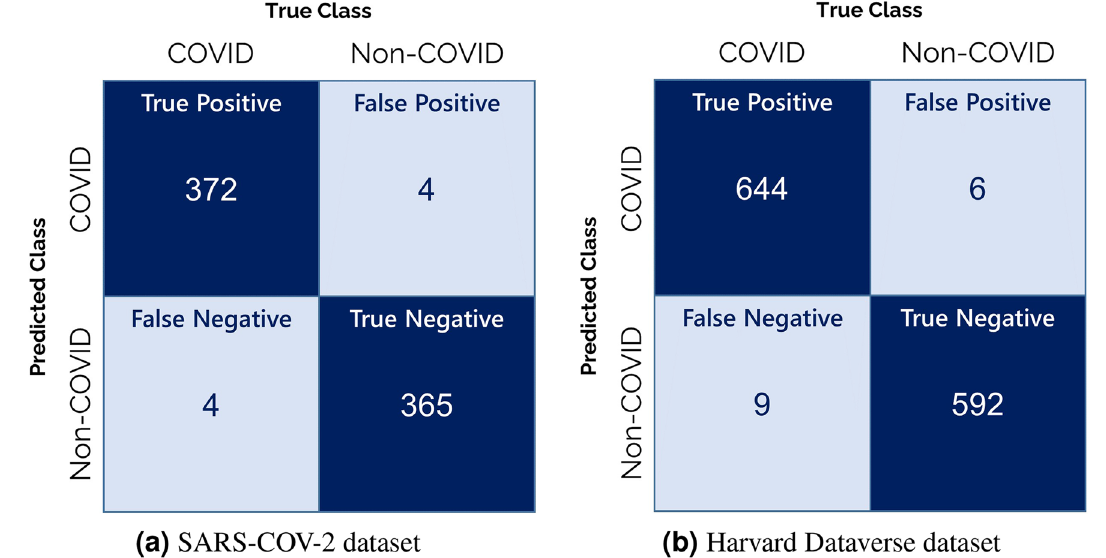
Figure 3. Confusion matrices obtained by the proposed ensemble model on the two datasets considered in the present work.